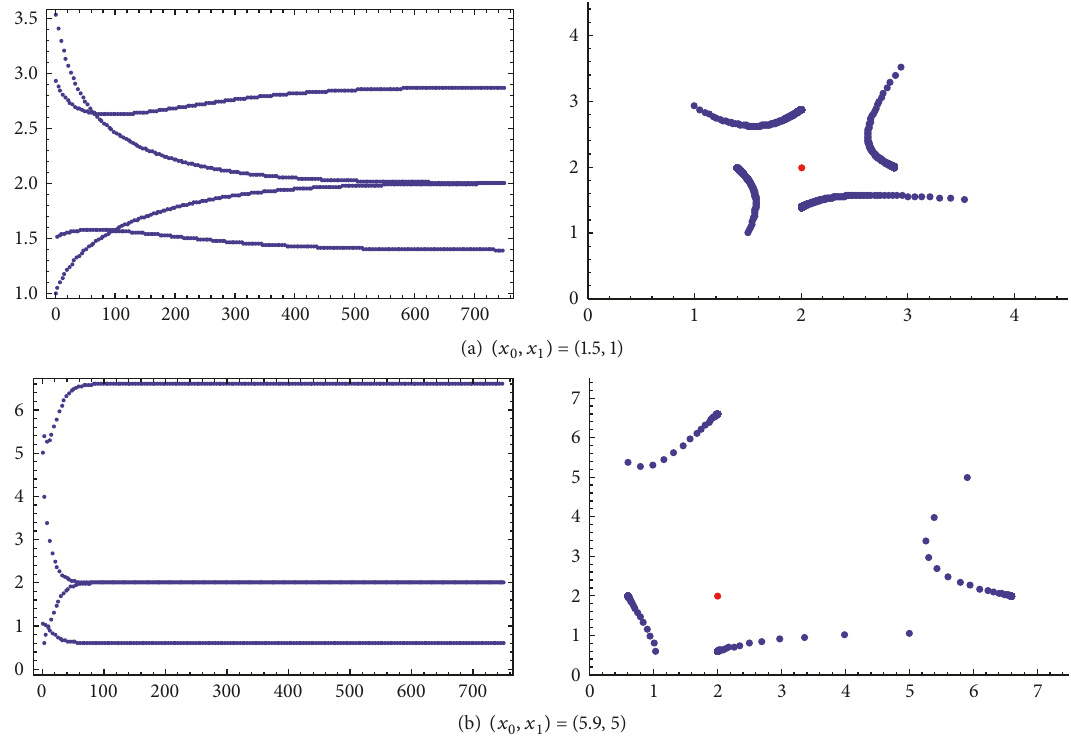
Figure 6: The orbit and phase portraits for 𝑏 = 1 , 𝑐 = 1 , 𝐵 = 2 , and 𝐹 = 𝐹 𝑔 = 𝐹 0 = 8 generated by Dynamica 4 [16].